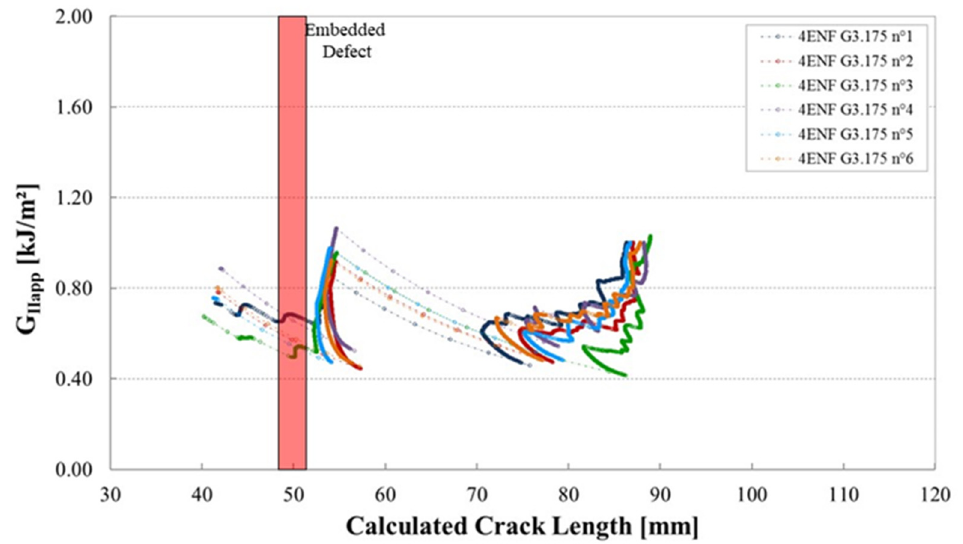
Figure 14. Mode II fracture energy as a function of the crack length for six 4ENF specimens containing a gap of 3.175 mm, plates manufactured with caul plate.